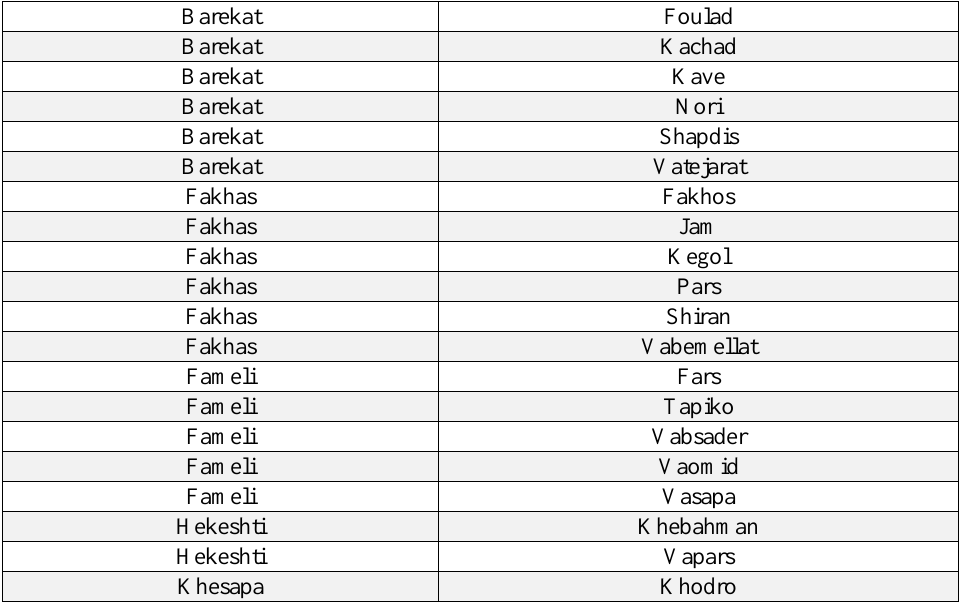
Table (3) Identify 20 pairs of shares